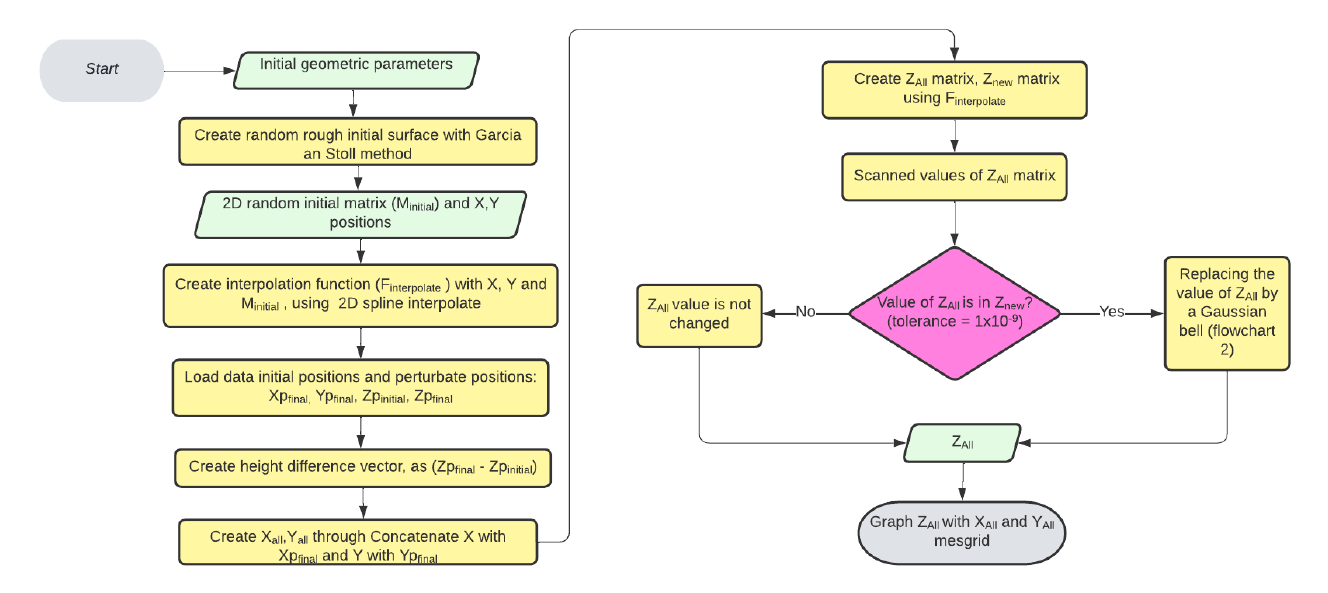
Figure 3. Flowchart 1, complete cycle of the deformation of a random surface.